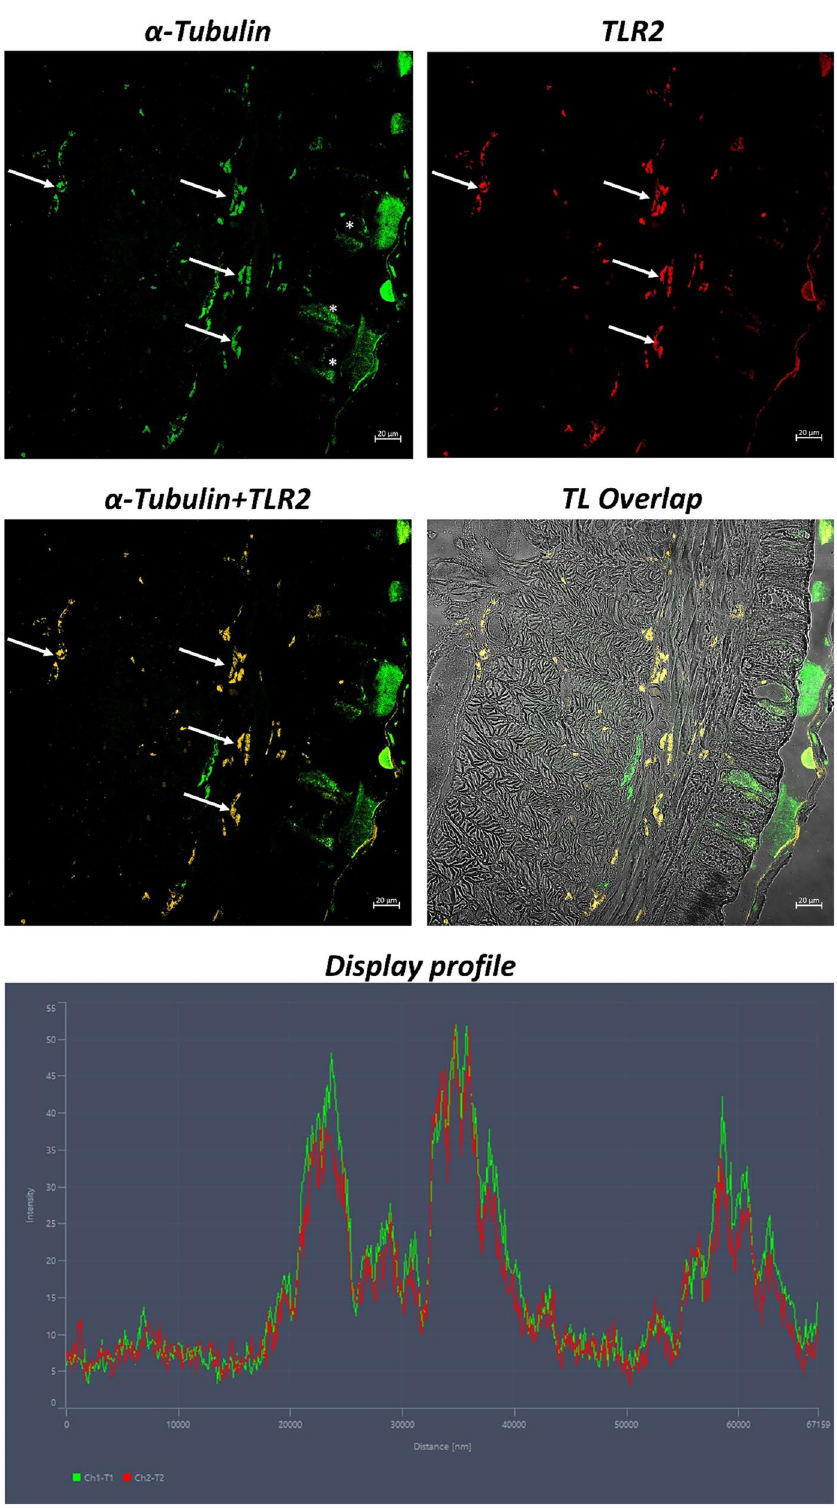
Fig. 3 Cross Sects. (5 μm thick) of Lumbricus terrestris . Sections are immunohistochemically treated with anti-TLR2 and anti-α-Tubulin antibodies. Magnification 20x. Coelomocytes immunoreactive for antibodies tested are evident and colocalized (arrows). In addition, some glandular mucous cells are positive for α-Tubulin (*). The “Display profile” function confirms these data. TL